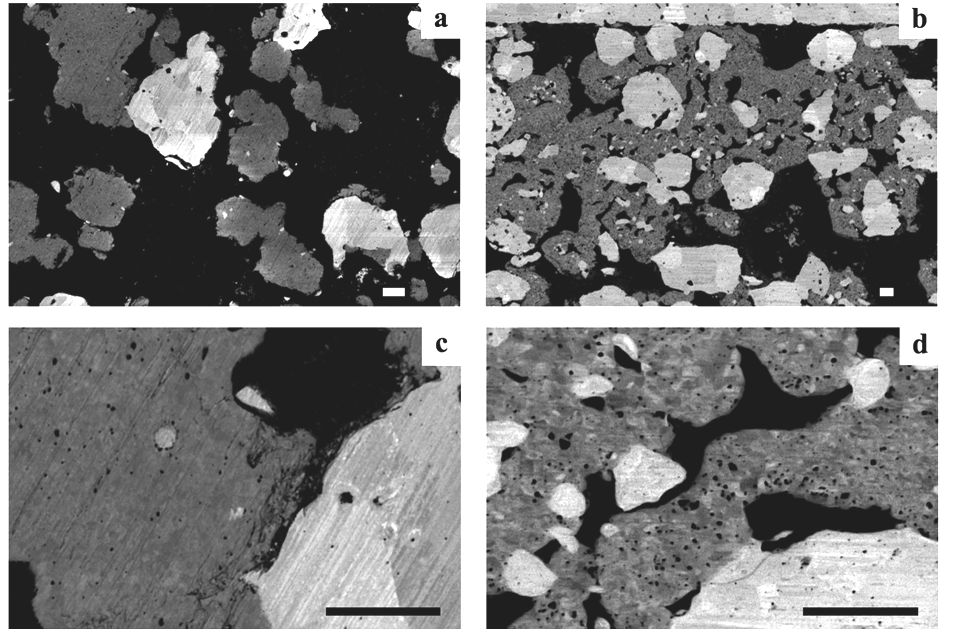
in N ) ( a ) and ( c ): fresh as-sintered sample, and ( b ) and ( d ): tested sample gas (10% H 2 2 from Figure 27. The grey levels separate each phase (YSZ: light grey, Ni: dark grey and porosity: black). All data-bars are 2 µm in length